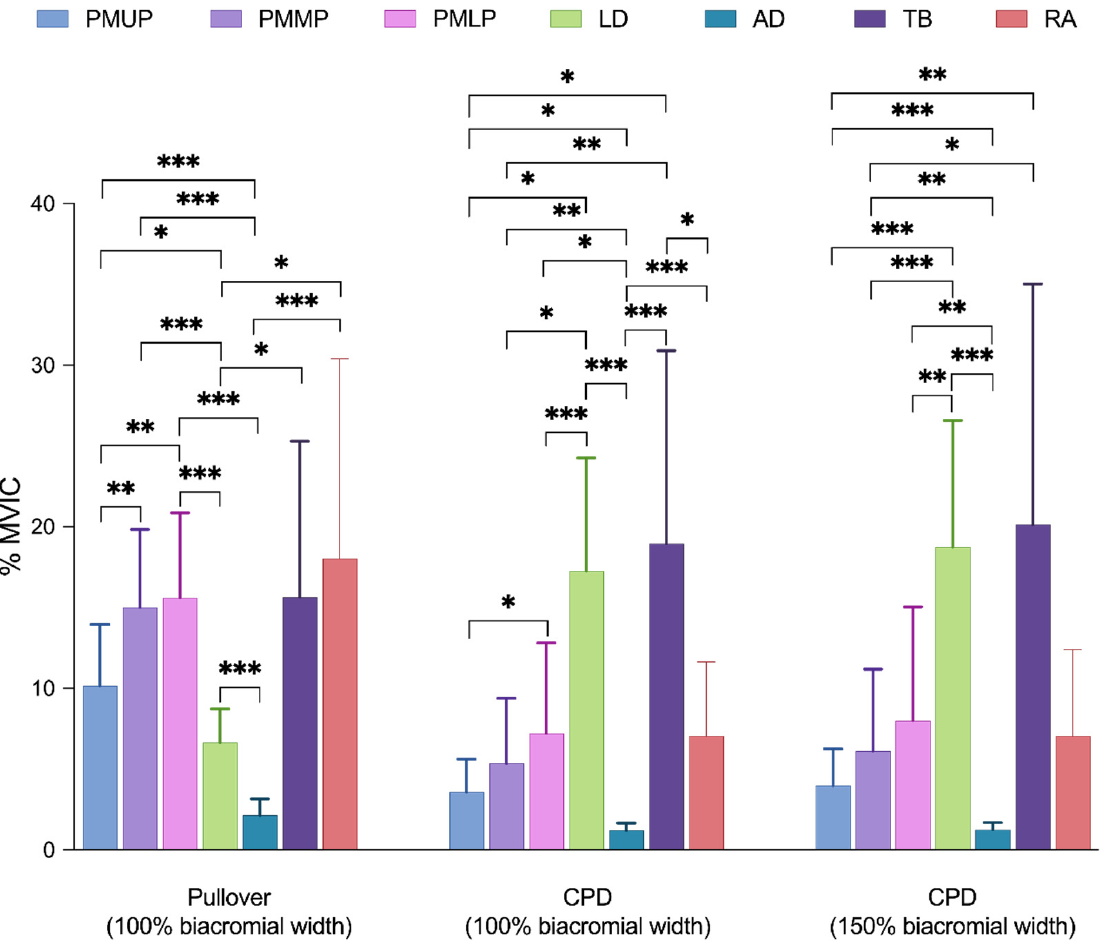
Figure 3. Mean EMG activity and standard deviation normalized to the maximal voluntary isometric contraction (MVIC) in the barbell pullover at 100% biacromial width and straight arm pulldown exercises at 100% and 150% biacromial widths. * p < 0.05; ** p < 0.01; *** p < 0.001.